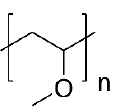
Figure 14. Poly(methyl vinyl ether) (PMVE).